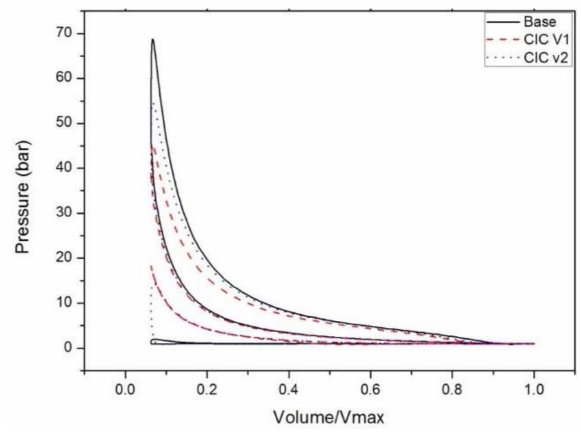
Figure 8. P-V diagram for three different recompression